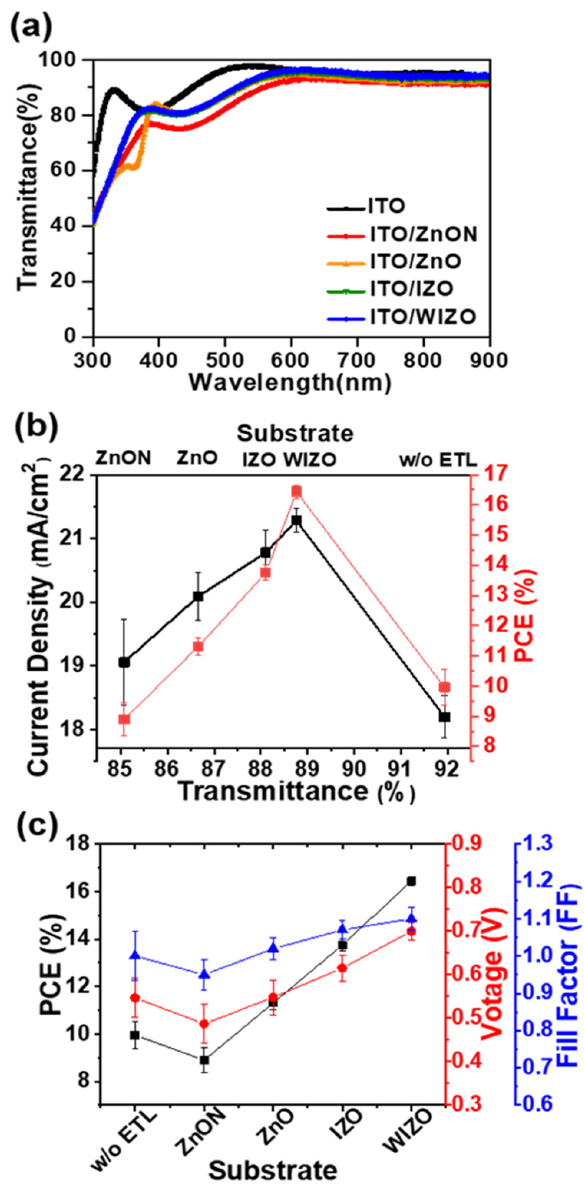
Figure 5. E ff ect of optical properties on solar cell performance. ( a ) Optical transmittance of metal Figure 5. Effect of optical properties on solar cell performance. (a) Optical transmittance of metal oxide oxide films deposited on ITO substrates. ( b ) Current density and power conversion e ffi ciency versus films deposited on ITO substrates. (b) Current density and power conversion efficiency versus transmittance, and ( c ) e ff ect on perovskite PCE, V OC , and FF in di ff erence metal oxide substrate of transmittance, and (c) effect on perovskite PCE, V OC , and FF in difference metal oxide substrate of PSCs.